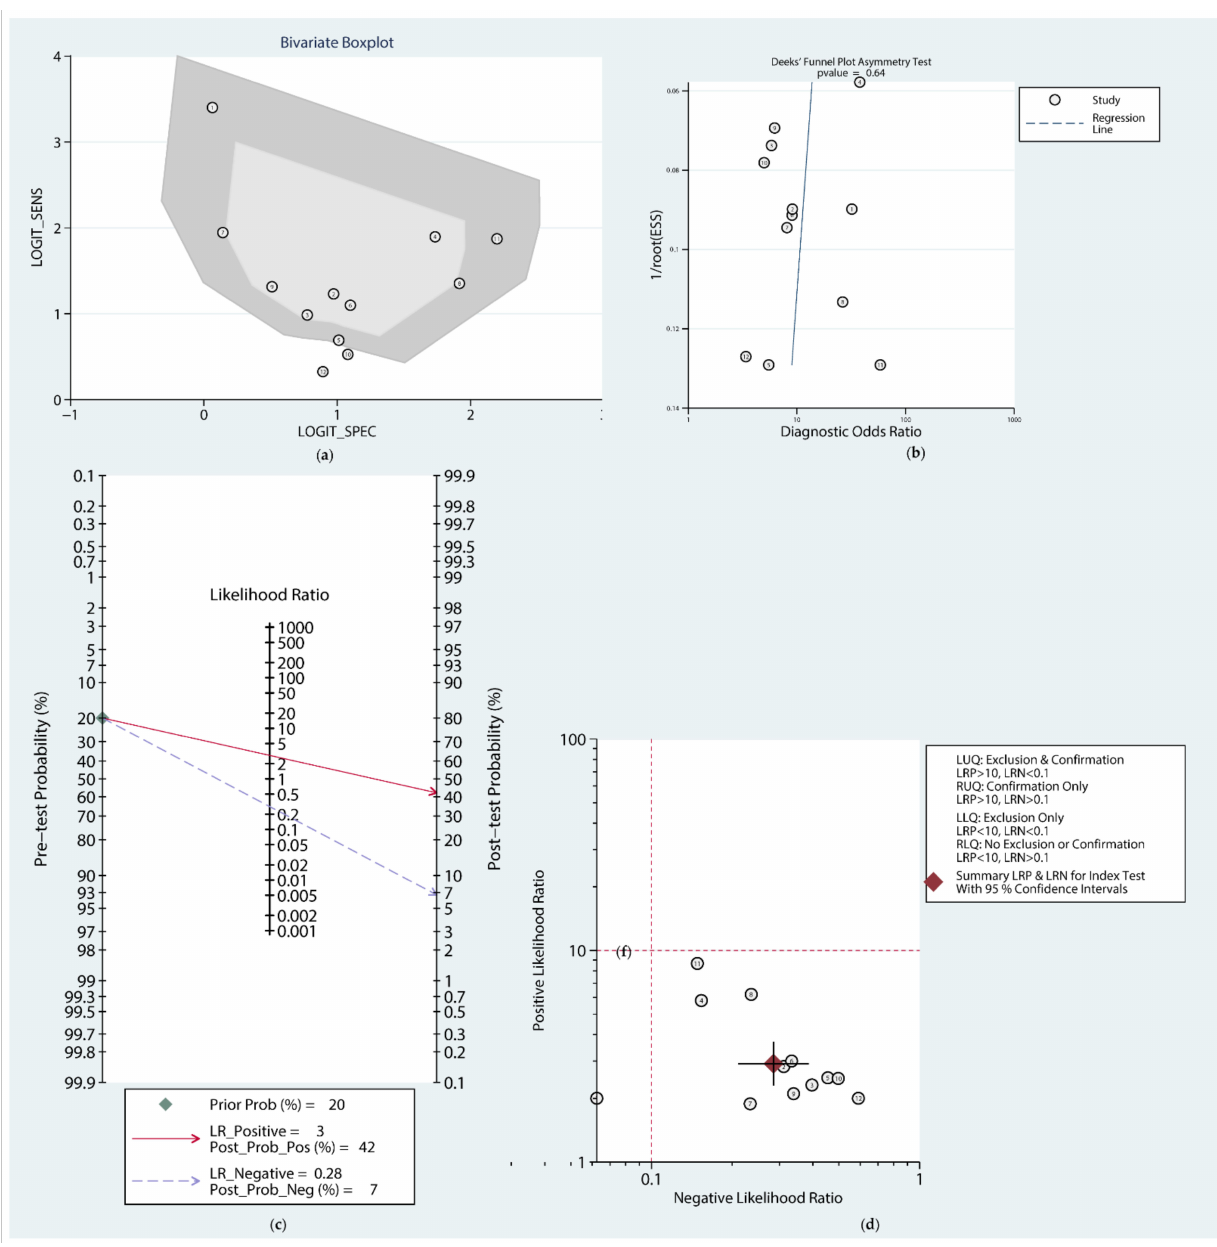
Figure 4. Bivariate boxplot ( a ), Deeks’ funnel plot ( b ), Fagan’s nomogram ( c ), and Scatter plot of PLR and NLR ( d ) to illustrate the diagnostic accuracy of circRNAs in pancreatic cancer. “LRP” and “LRN” in the text within Figure 4d refer to the labels of Y -axis (Positive Likelihood Ratio, PLR) and X -axis (Negative Likelihood Ratio, NLR),